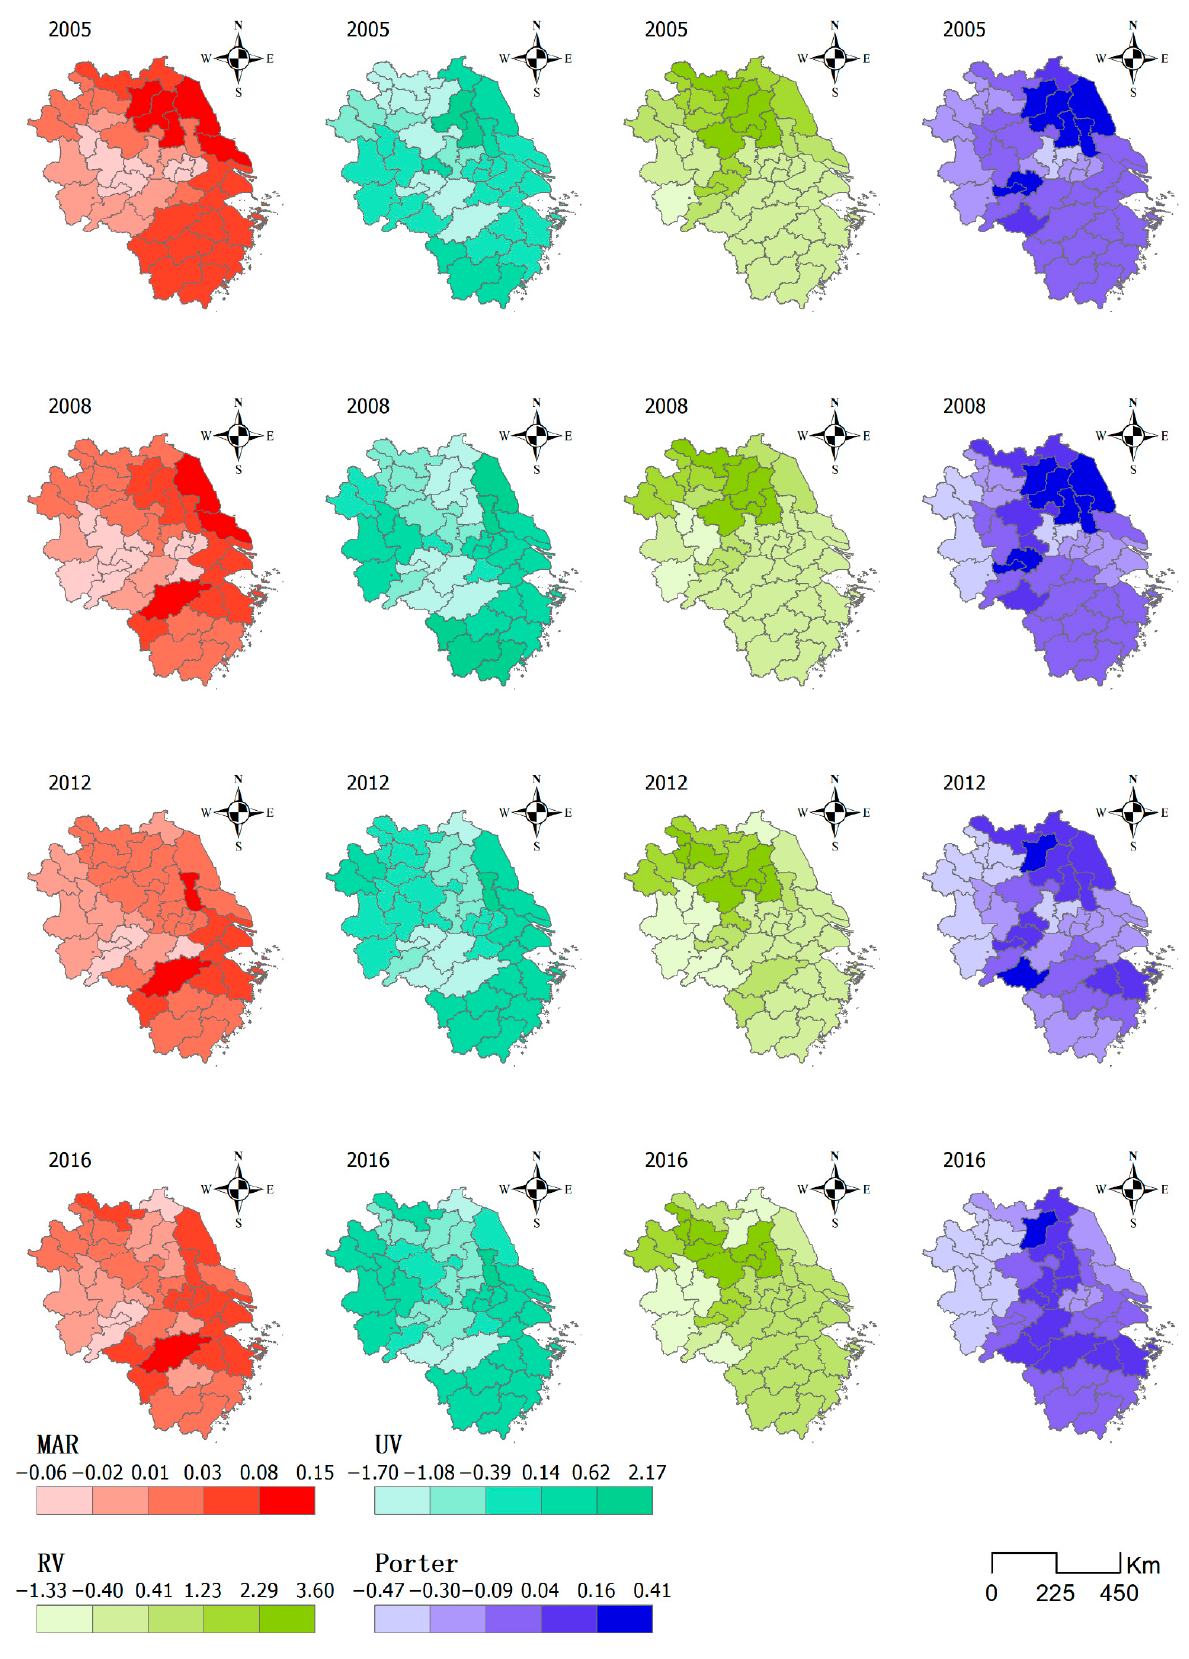
Figure 8. Spatiotemporal distribution of